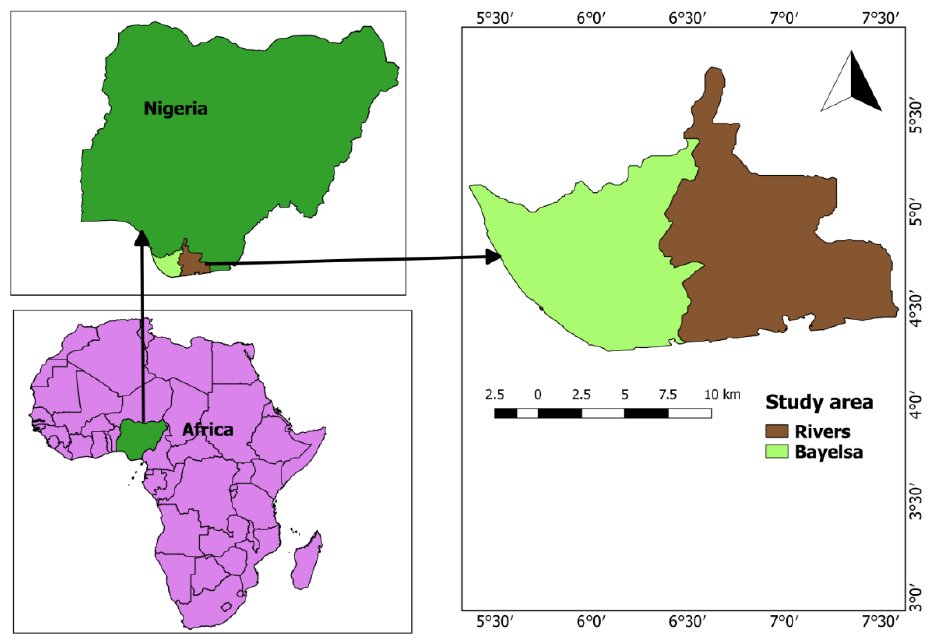
Figure 2. Location of the study in Niger Delta showing Rivers and Bayelsa states.